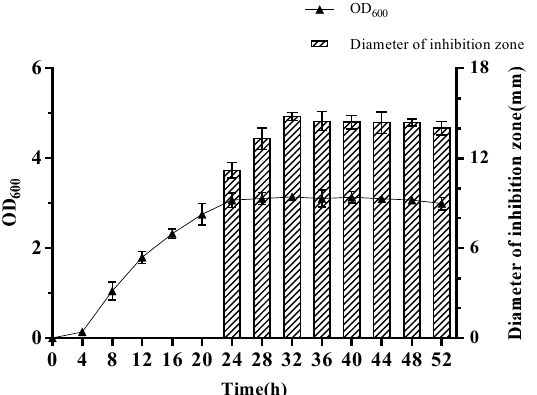
Figure 1. Growth and dynamics of antimicrobial substance production by W. coagulans PL-W.